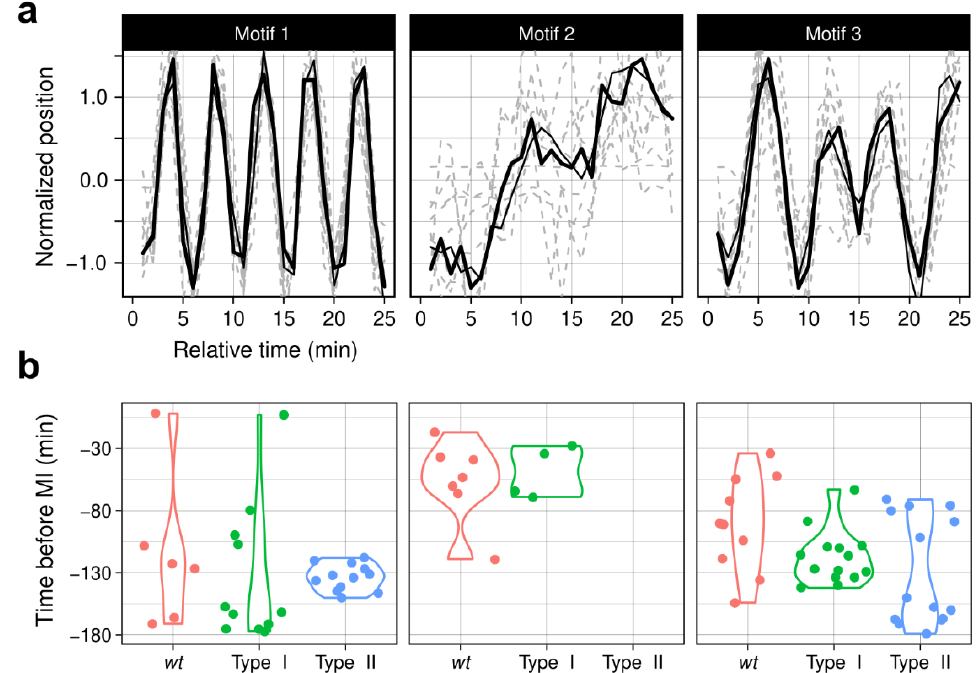
Figure 5. Discovery of motifs in the dataset, for wt , Type I and II (synthetic) datasets. ( a ) 3 motifs, discovered using a time-window of 25 min, are shown. In each motif plot, a maximum of 100-top matches are aligned. ( b ) violin-plot illustrating the time distribution of each motif for each group.